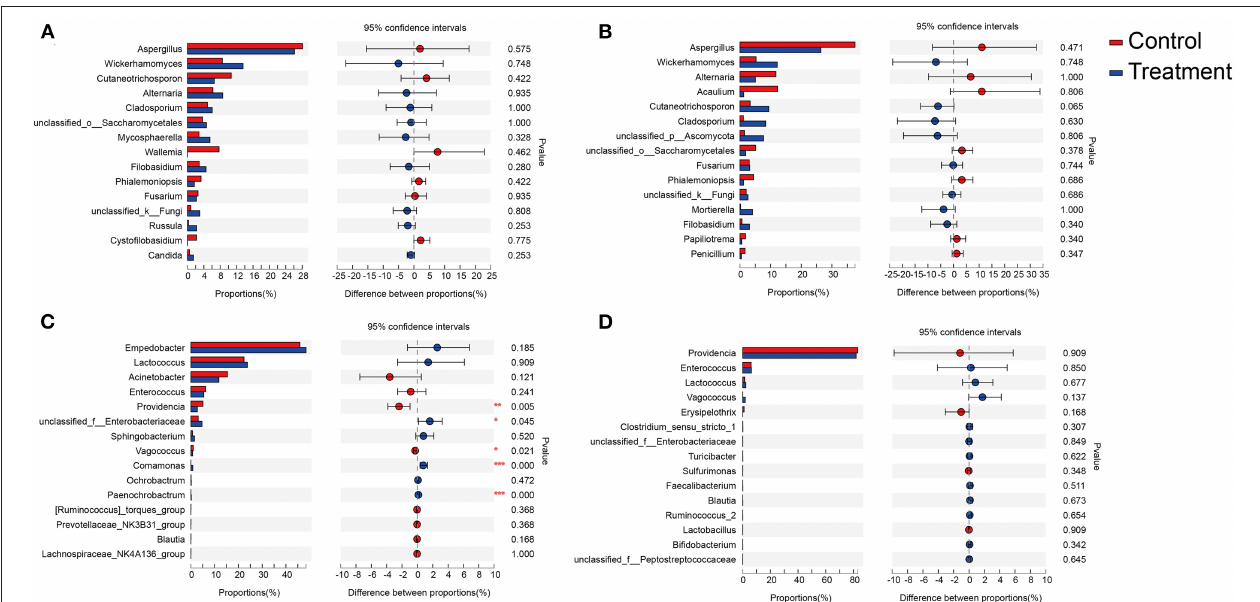
FIGURE 4 | Relative abundances of the top 15 fungal and bacterial genera in body surface samples and gut samples of D. antiqua larvae. (A–D) The relative abundance comparison of fungal genera from body surface, fungal genera from gut, bacterial genera from body surface, and bacterial genera from gut, respectively. Student’s t- test was used to evaluate the significance of differences between the control group and B. bassiana- treated group. “Control” represents samples from D. antiqua larvae treated with sterilized PBS, and “treatment” represents samples from D. antiqua larvae treated with B. bassiana conidial suspension. Asterisk (*) denotes a significant difference between the two groups (0.01 < p ≤ 0.05 marked as *, 0.001 < p ≤ 0.01 marked as **, and p ≤ 0.001 marked as